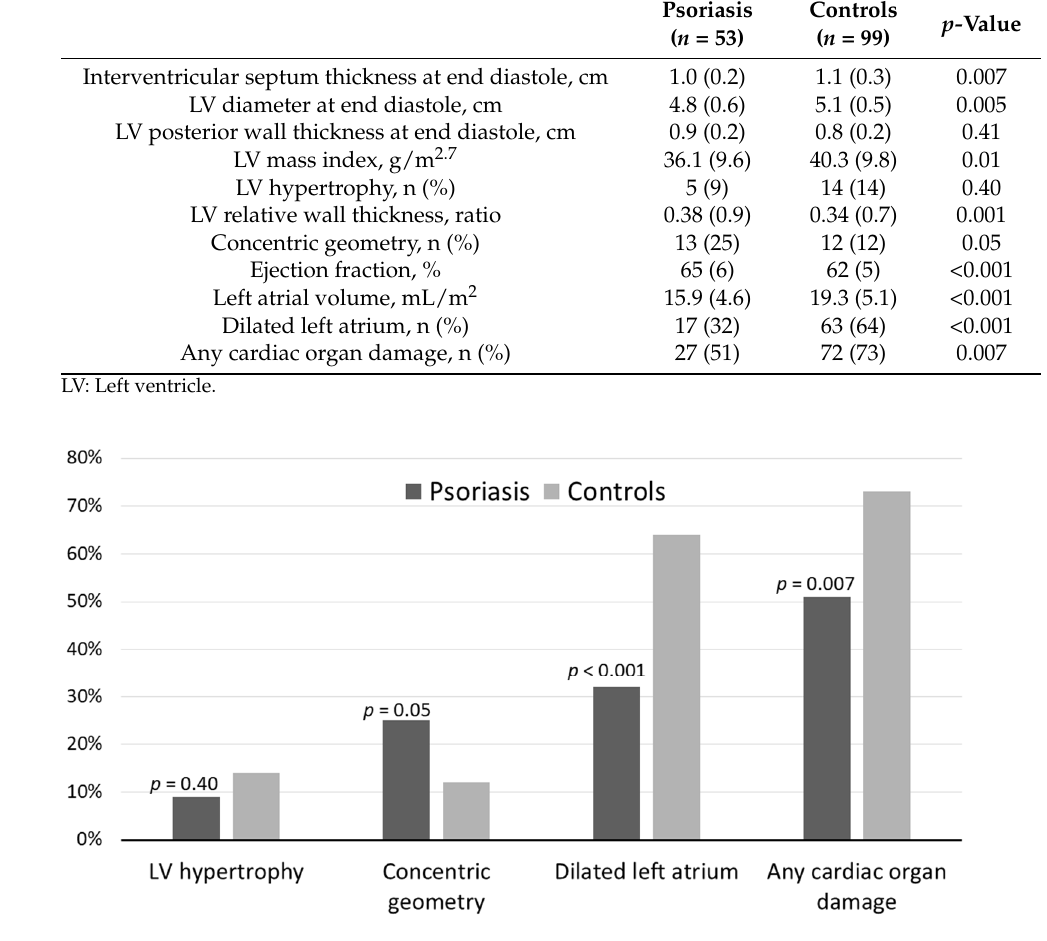
Figure 1. Subclinical cardiac organ damage in psoriasis patients and controls. LV: Left ventricle